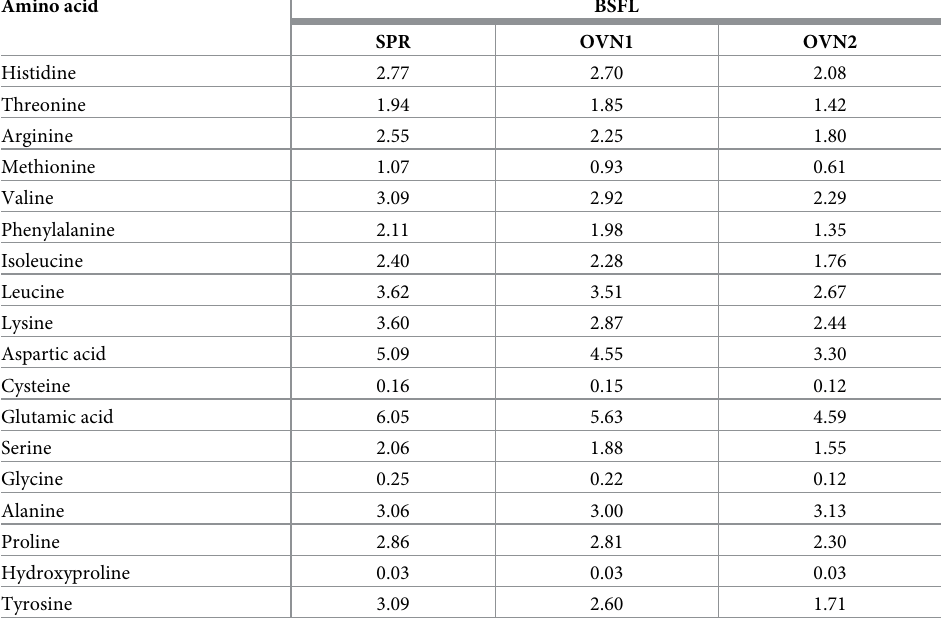
Table 2. Amino acid composition of the BSFL (%